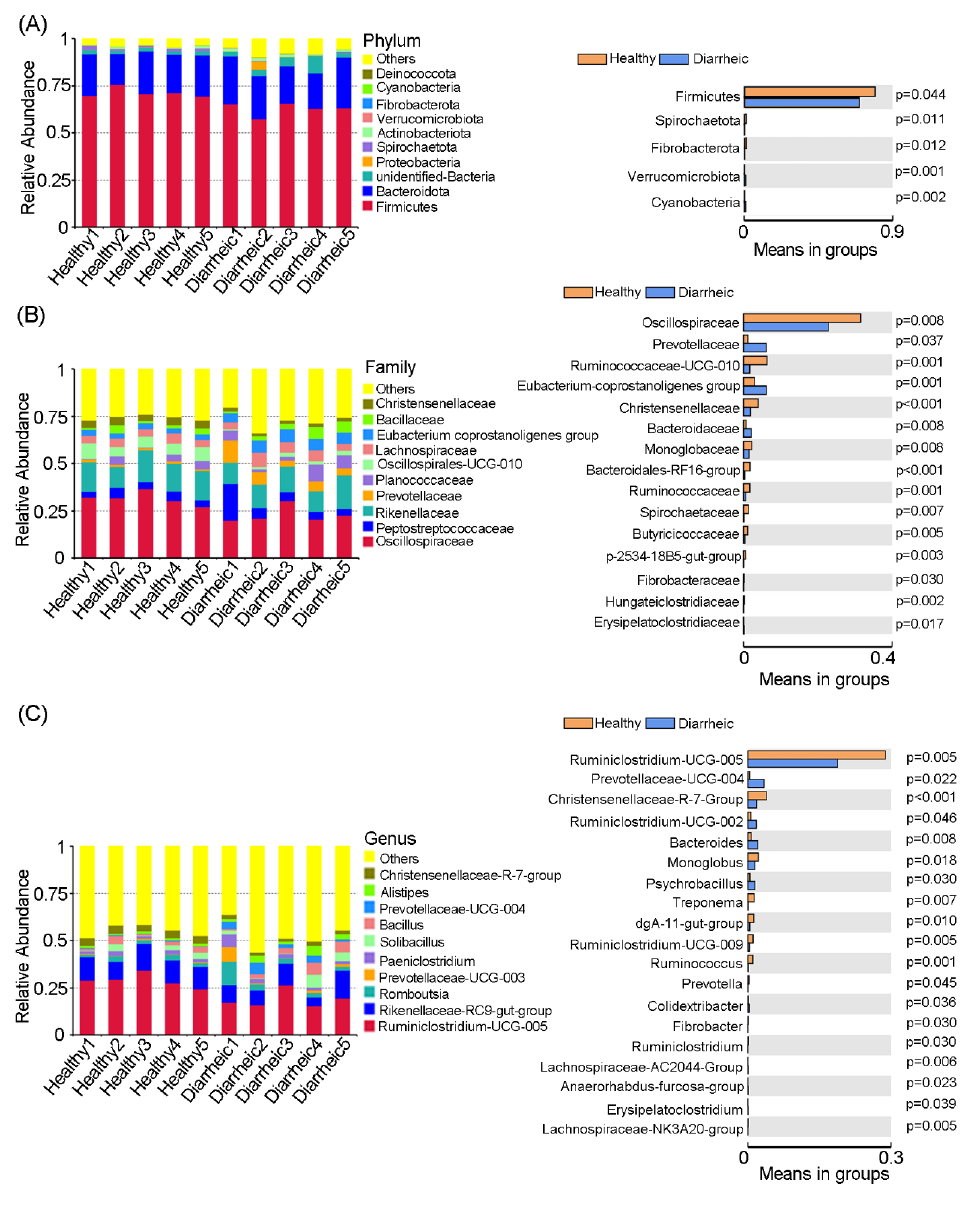
Figure 2. Gut microbiota comparisons between groups. Bacterial composition and comparisons were conducted at phyla ( A ), family ( B ), and genus ( C ) levels based on relative abundance. Data were presented as the mean ± SEM ( n = 5